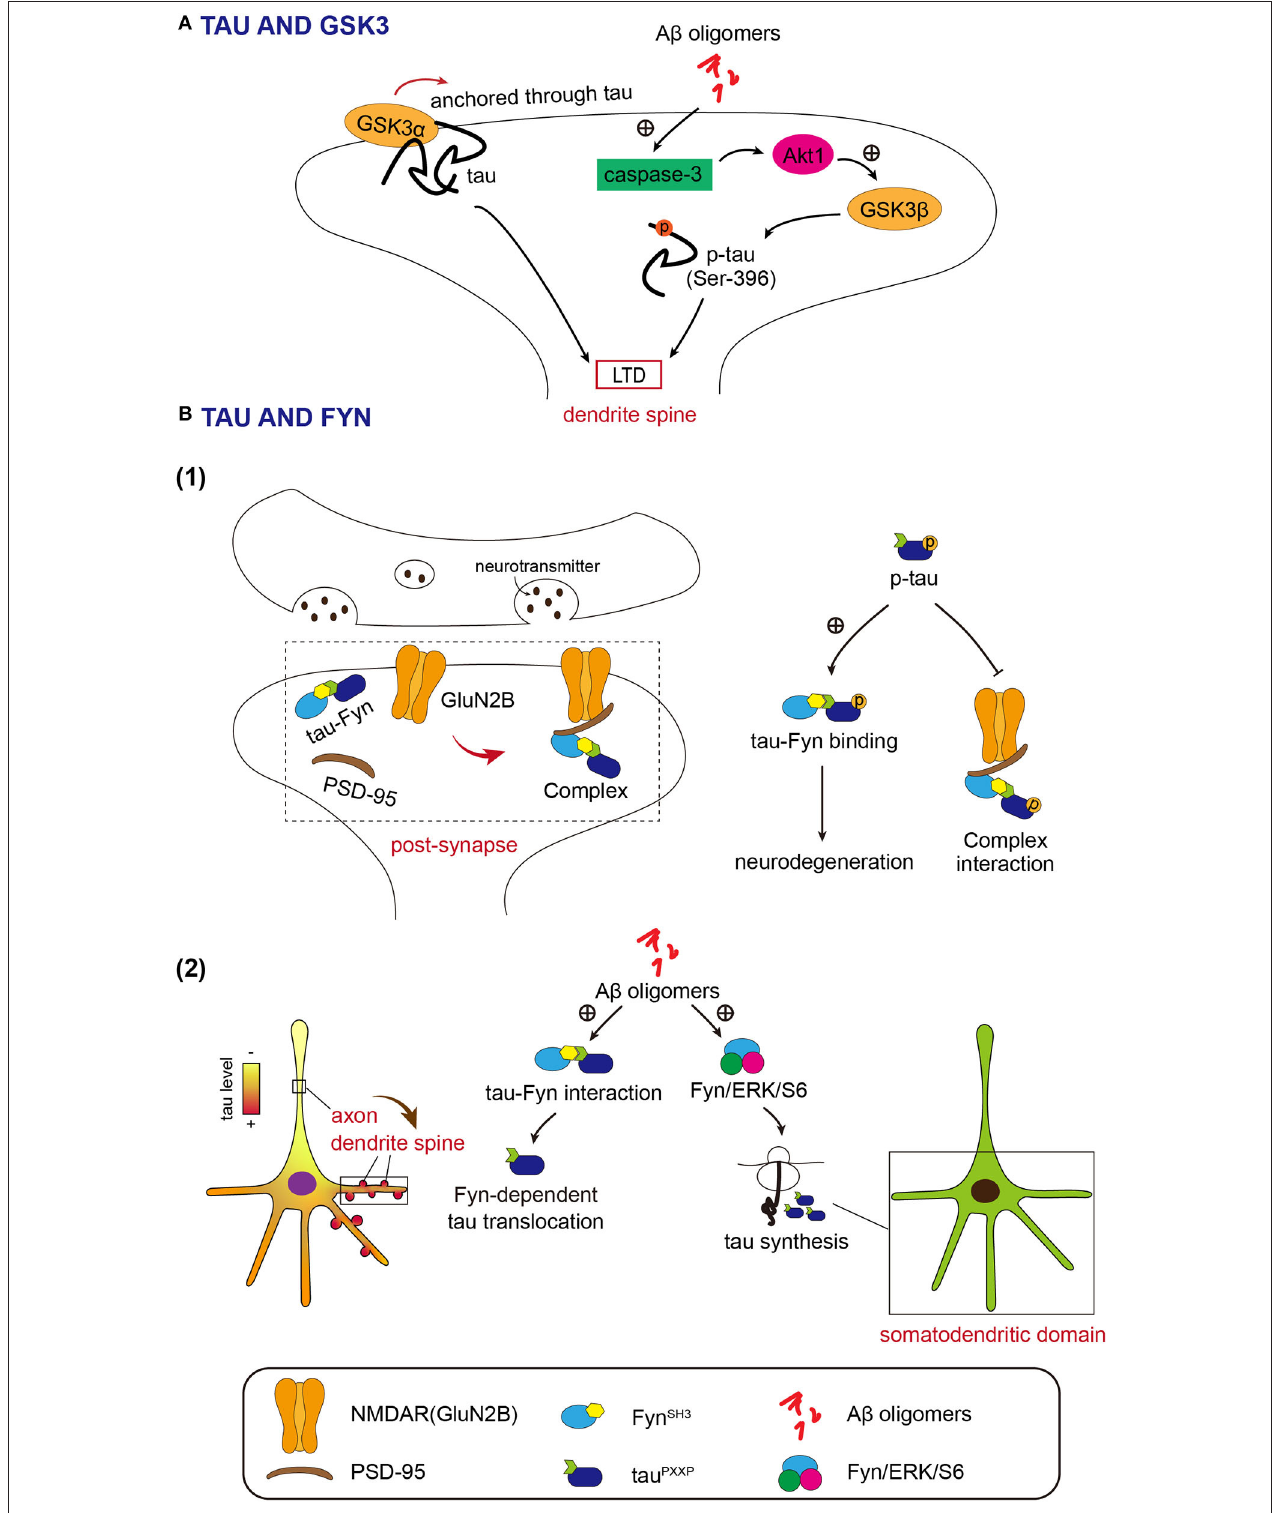
FIGURE 1 | (A) Both GSK3 α and GSK3 β function in long-term depression (LTD) depends on tau. Activated GSK3 β resulted from Akt1 cleavage by A β , phosphorylates tau in the synaptic compartment at Ser 396 to initiate LTD. GSK3 α induces LTD by entrance into the dendrite spine temporarily via tau. (B) Fyn acts in the dendrite spine closely associated with tau. (1) Fyn-tau-PSD-95-NMDAR complex. Fyn interacts with tau via the SH3 domain and targets both PSD-95 and GluNR2B subunit